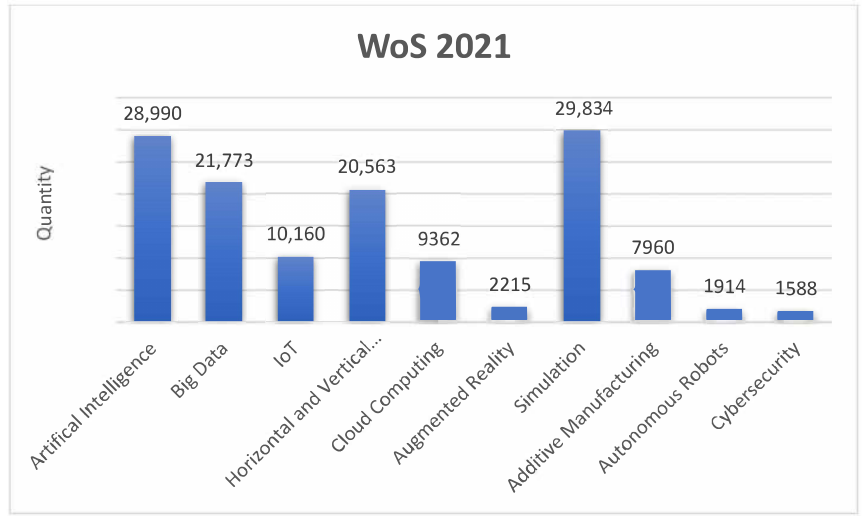
Figure 5. Number of articles mentioning attributes in the Web of Science database for